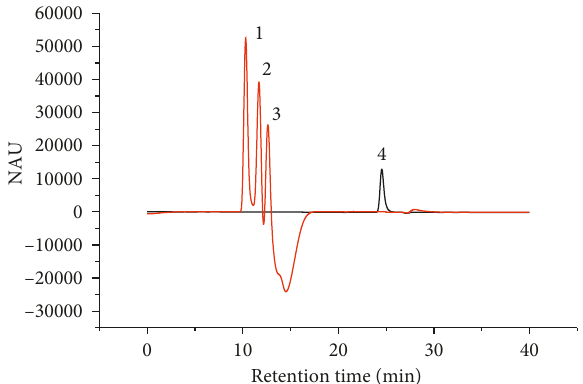
Scheme 1: The structure of derivatized glucose.